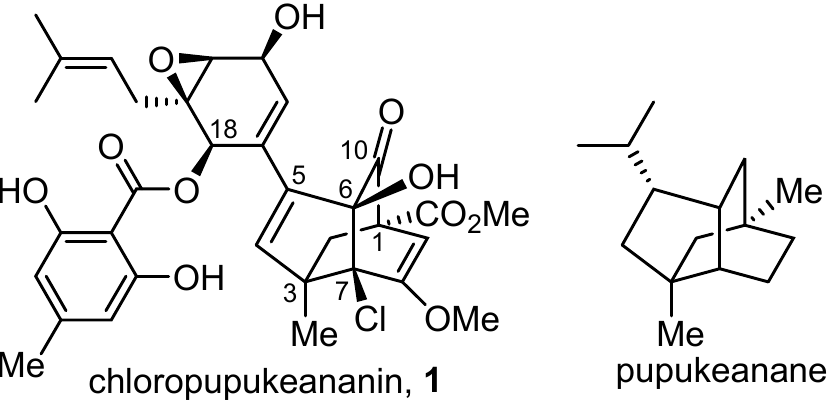
Figure 1. The chemical structure of chloropupukeananin and pupukeanane.